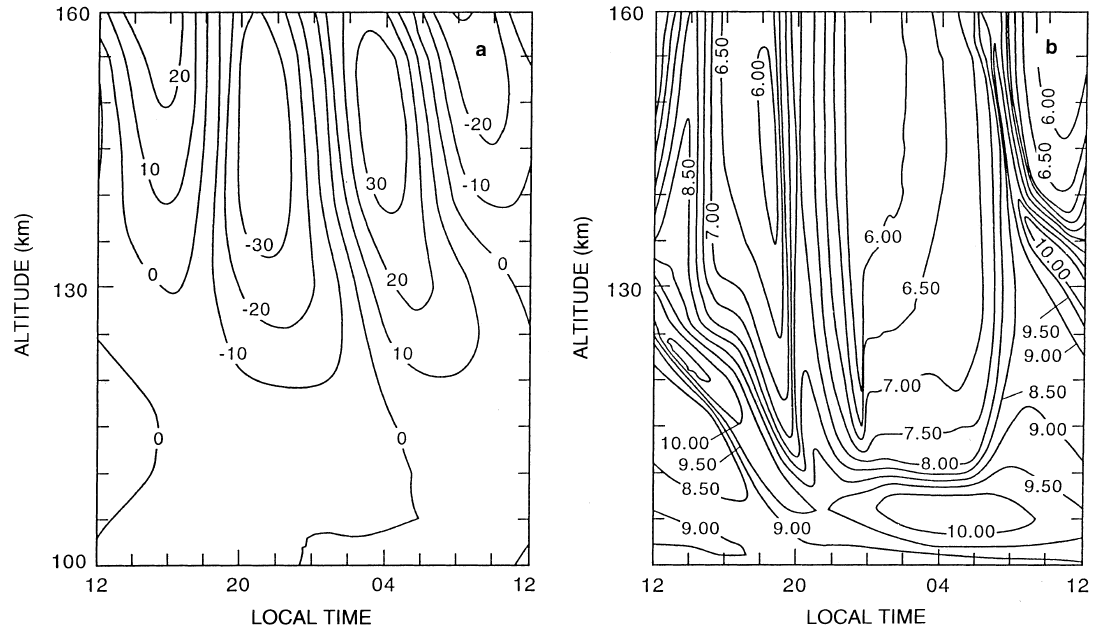
Fig. 11a, b. Same as Fig. 10, except at 22.5